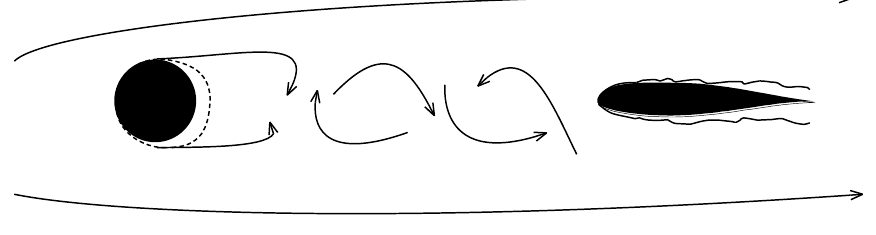
Figure 1. Surrogate model overview.